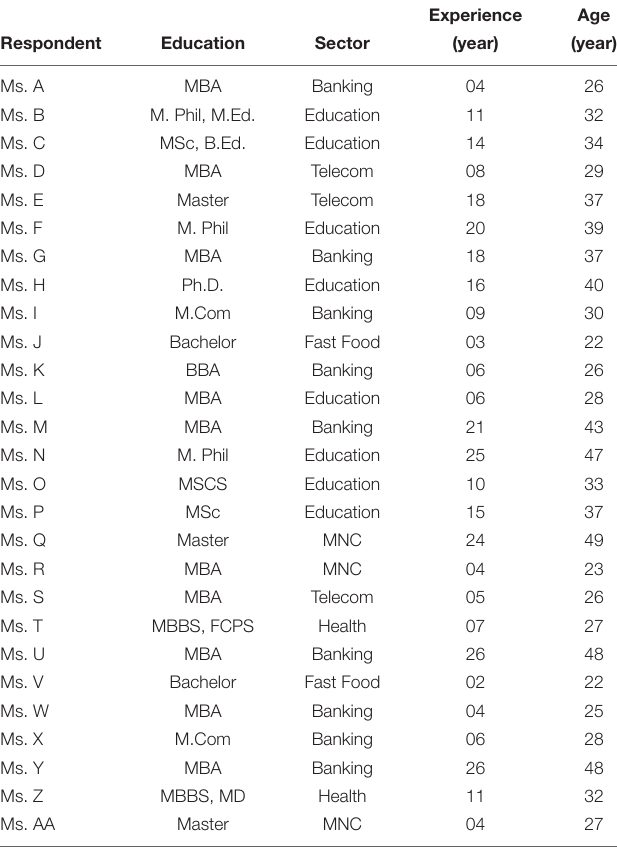
TABLE 1 | Respondent